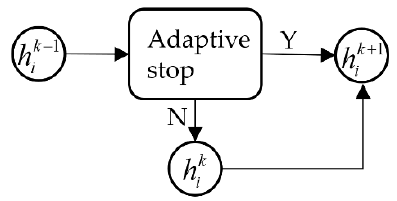
Figure 4. Adaptive propagation stop unit.